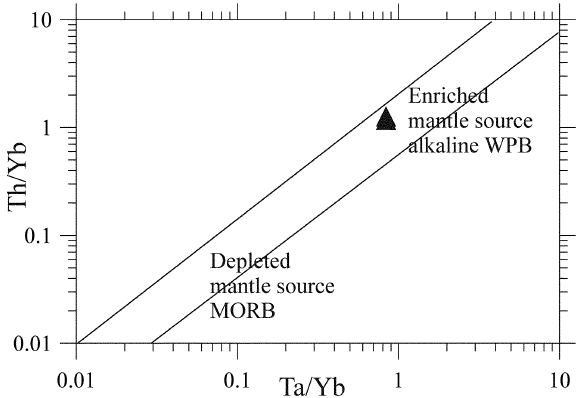
Fig. 9. Ta/Yb vs Th/Yb diagram for the dolerites from well D-1 (Pearce 1983, 1996). WPB, within plate basalt; MORB, middle ocean ridge basalt.